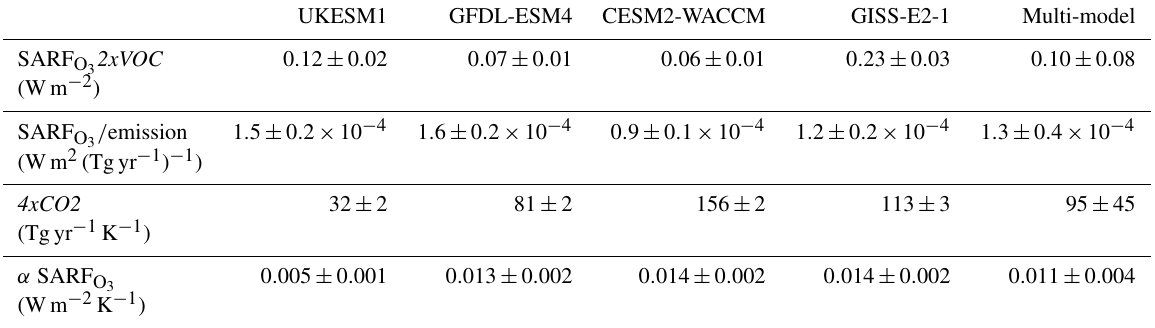
Table 10. Ozone SARF and radiative efficiencies for 2xVOC emissions. Changes in emissions are from the 4xCO2 experiment. α values are calculated using the ozone SARF. Uncertainties for each model are errors in the mean based on interannual variability and assuming a 15% uncertainty in the ozone radiative efficiency (Sect. 2.2). Uncertainties in the multi-model results are the standard deviation across the models.